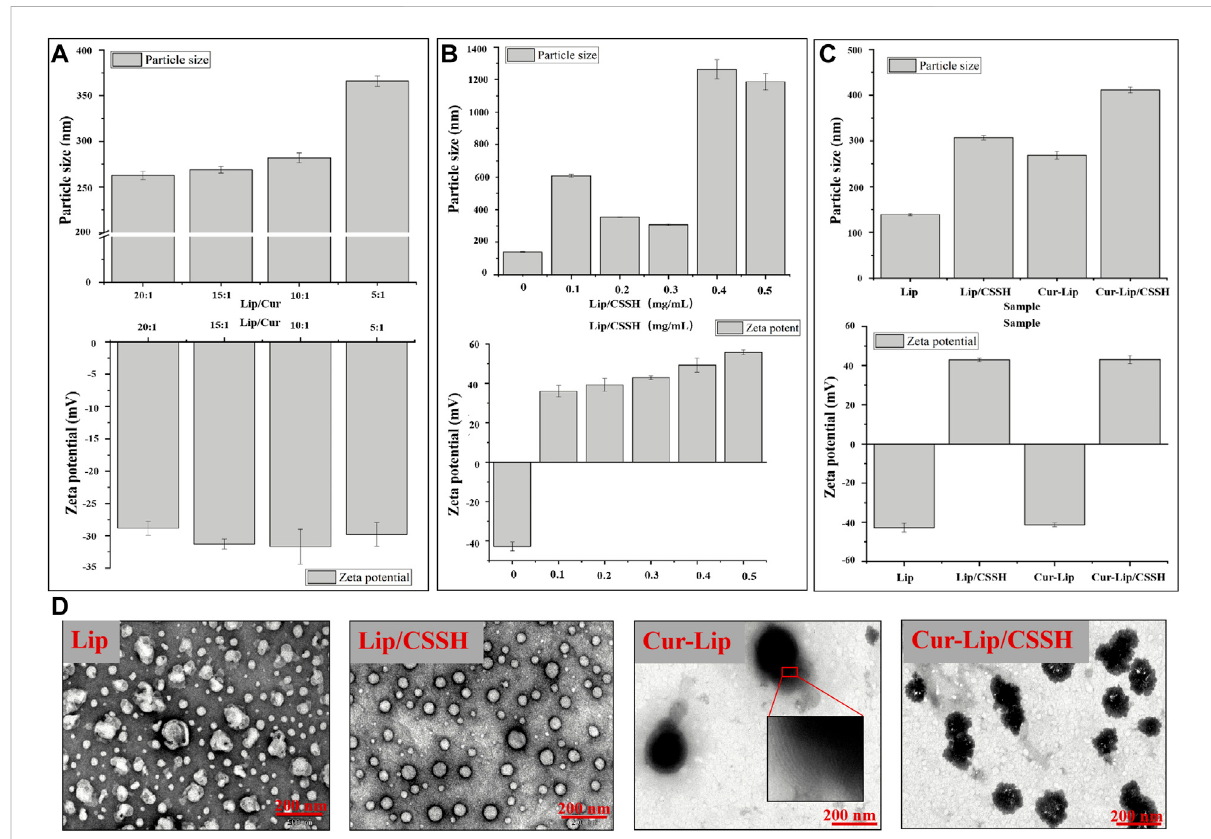
FIGURE 3 Effects of different Lip/Cur ratios on the performance of Lips (A) . Particle sizes and zeta potentials of the Lips after modi fi cation with different concentrations of CSSH (B) . Particle sizes and zeta potentials of the samples (C) . TEM images of the samples (D)